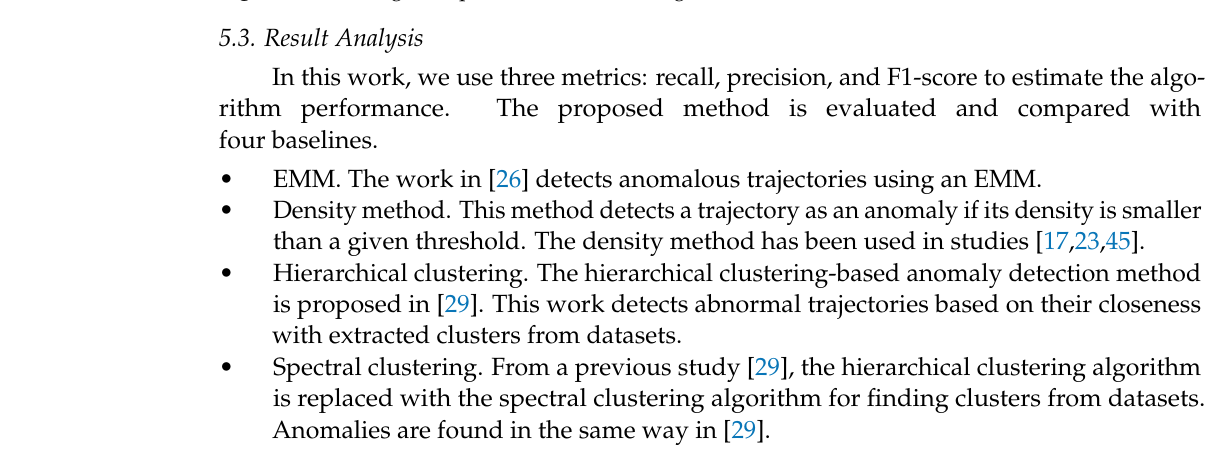
Figure 9. Selecting the Eps value: ( a ) MIT Badge dataset. ( b ) sCREEN